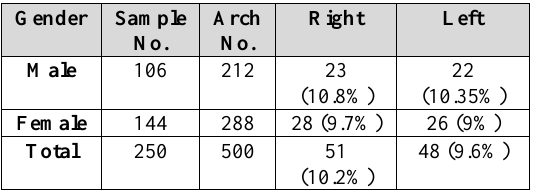
Figure 3: Distribution of malposed canine in different classes of malocclusions The direction of malposed canines Concerning the direction (right & left) of malposed canine, the distribution of malposed right canine was slightly higher (10.2%) than the left (9.6%), (as shown in table 4). Table 4: Distribution of malposed canines according to the